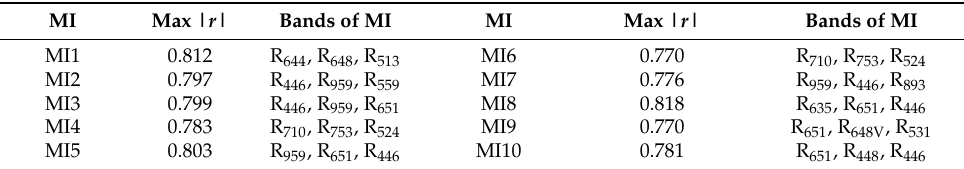
Figure 7. Optimal slice maps of the correlation coefficients between the SMC and the MI based on spectral bands. The color bars represent the correlation coefficients between the SMC and MIs, and the X-axes, Y-axes, and Z-axes are the respective wavelengths that represent the three bands of the MIs. The intersections of the three slices are the absolute maxima of the correlation coefficients: ( a ) MI1; ( b ) MI8. Table 5. The max |r| of MI and its selected bands. MI Max | r